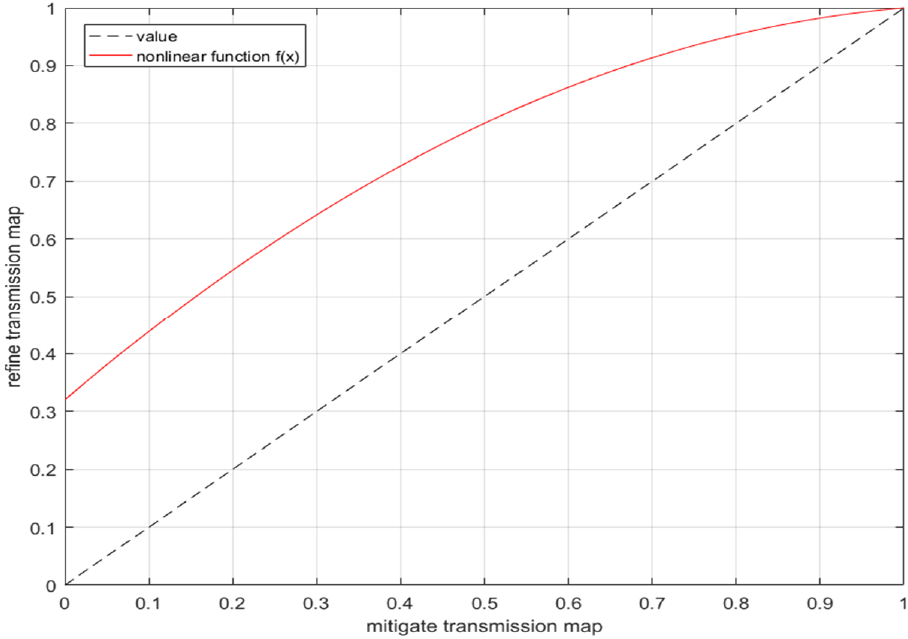
Figure 13. Nonlinear conversion function.